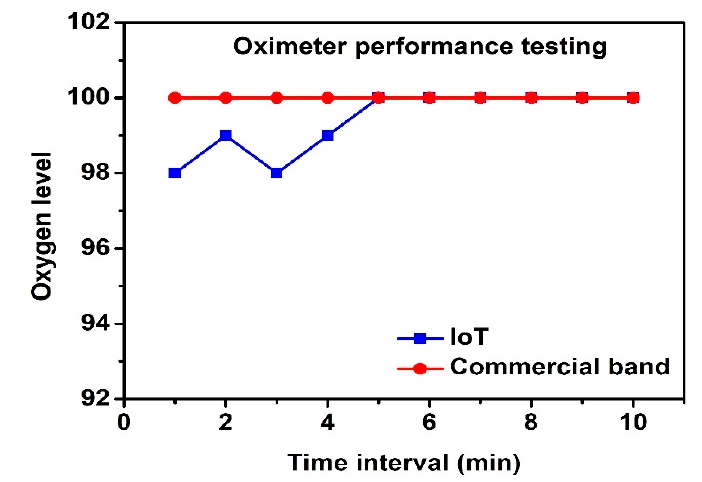
Figure 8. SparkFun sensor accuracy.